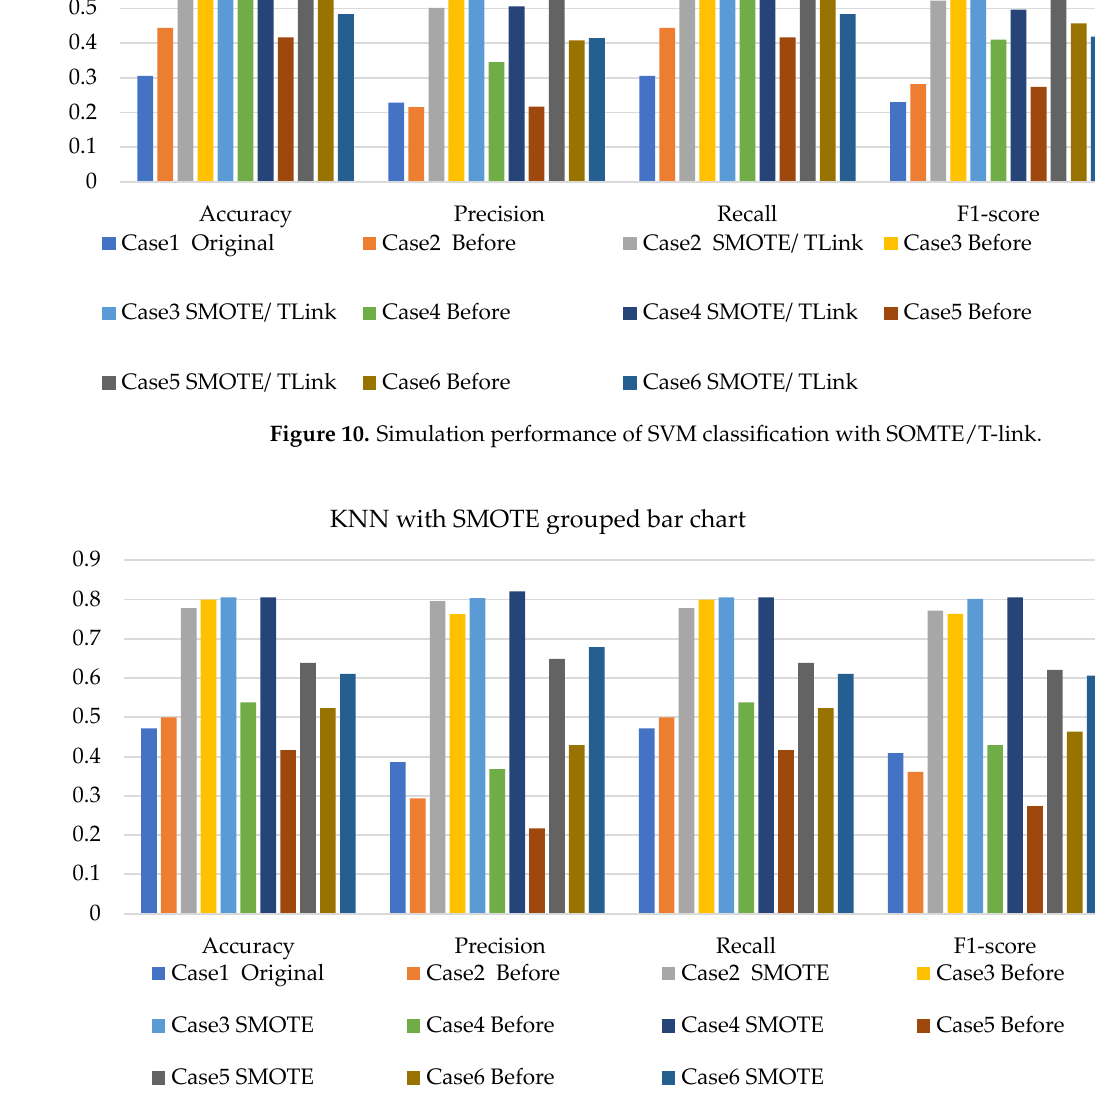
Figure 11. Simulation performance of k-NN classification with SMOTE.